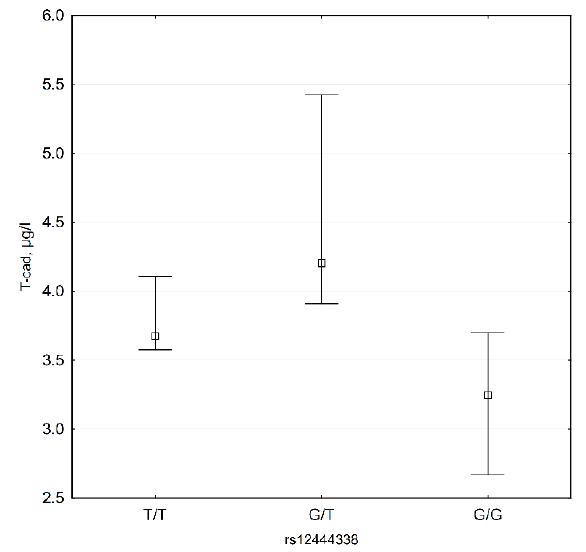
Figure 5. CDH13 rs12444338 genotypes and T-cadherin plasma levels ( n = 35).